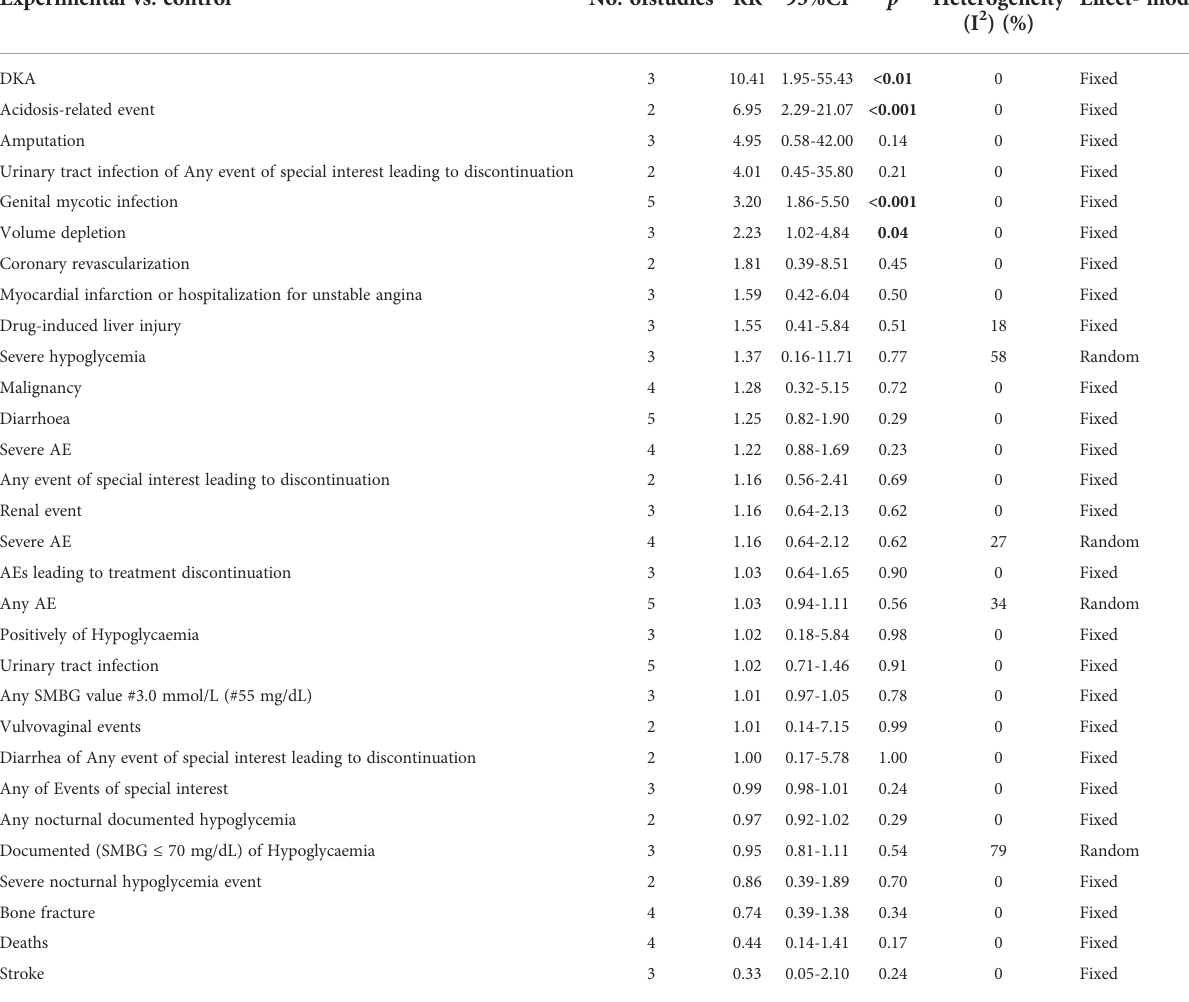
TABLE 3 Subgroup analysis of the adverse events (AEs) in sotagli fl ozin 200mg. Experimental vs.